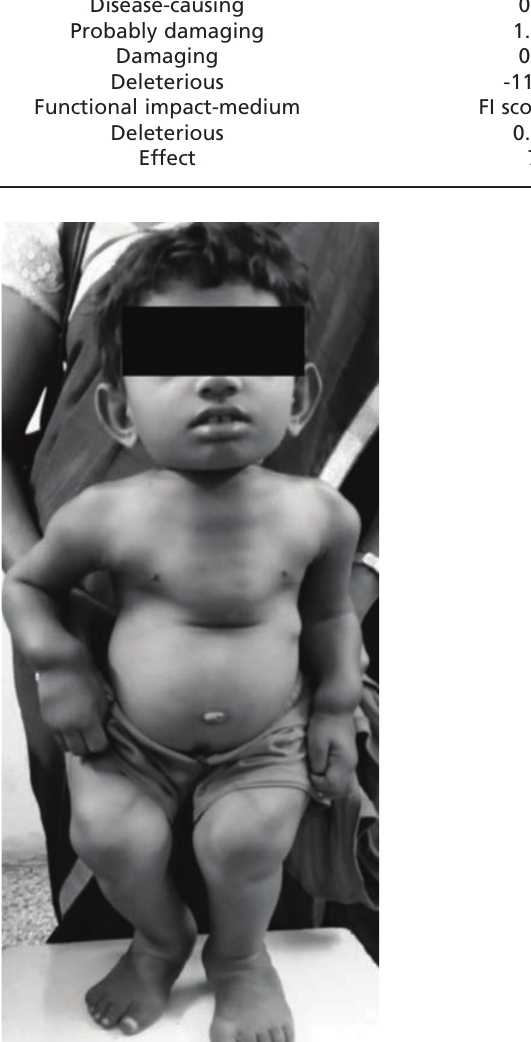
8-years-old girl with severe short trunk dwarfism, multiple joint contractures, pectus carinatum, protuberant abdomen and short Fig. 1: flexed lower limbs